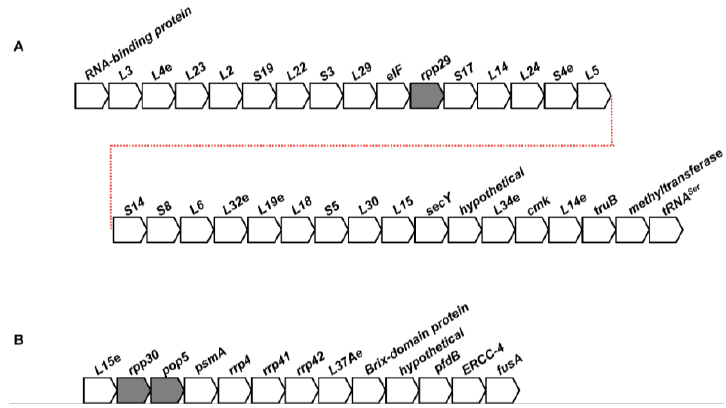
Figure 1. Putative ancestral loci of genes encoding RPPs. ( A ) RPP29 ( B )